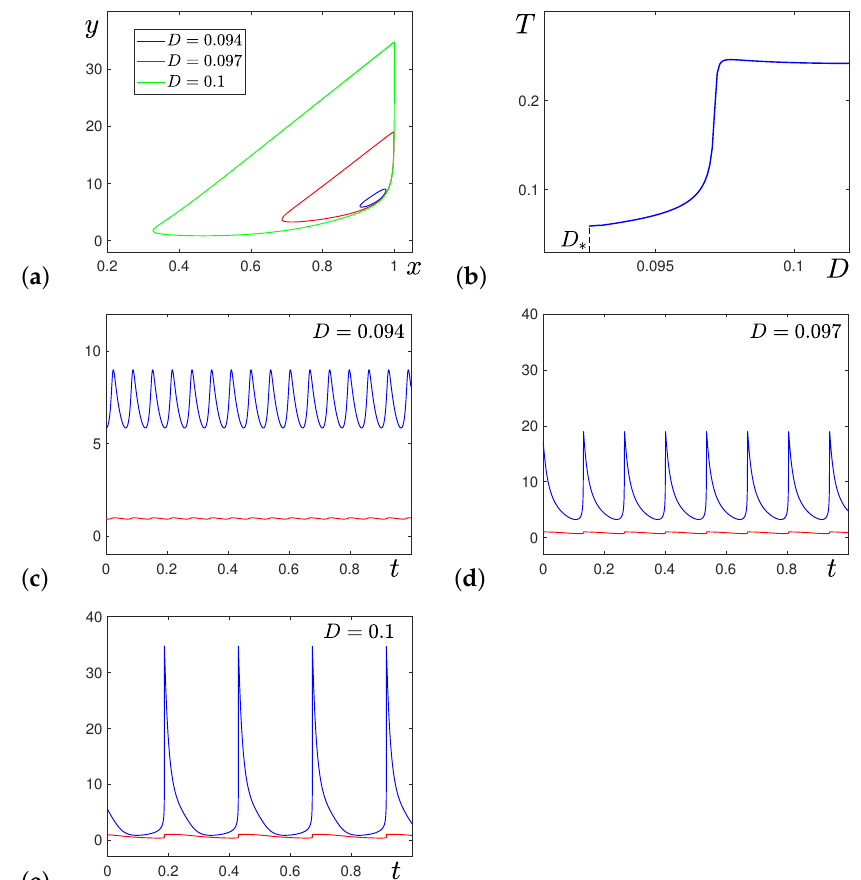
Figure 2. Self-oscillations in the parameter zone of the Canard explosion: ( a ) stable limit cycles; ( b ) period T ( D ) of oscillations; ( c – e ) time series for different values of the parameter D . In time series, x -coordinates are shown in red and y -coordinates are plotted by